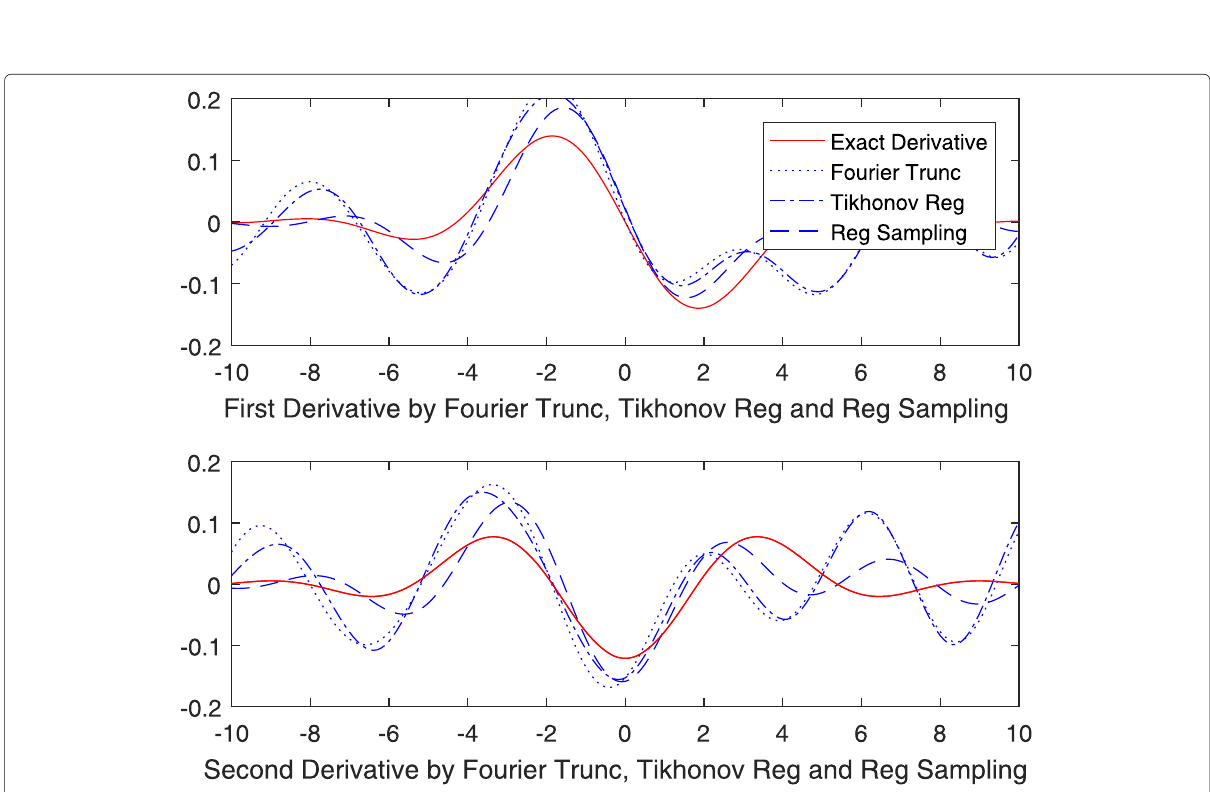
Fig. 9 The simulation results for the Gaussian noise in Example